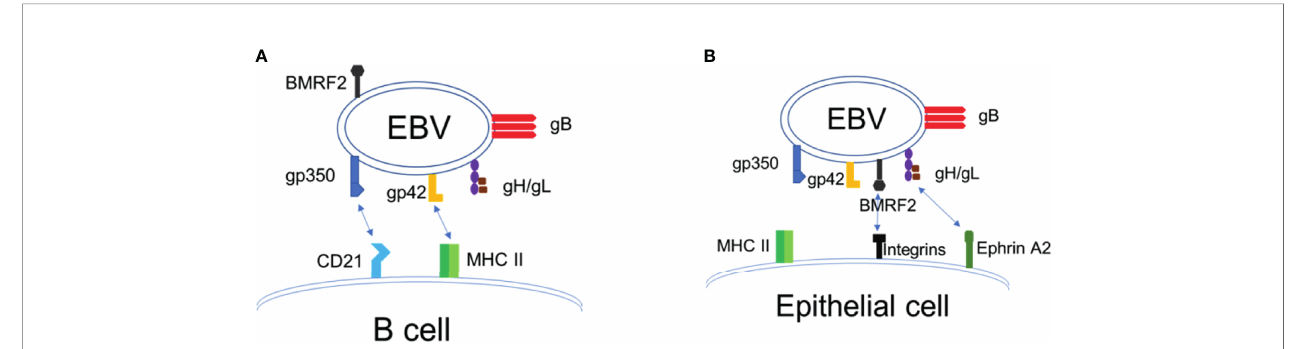
FIGURE 1 | EBV entry and infection of target cells. (A) EBV infection of B cells. (B) EBV infection of epithelial